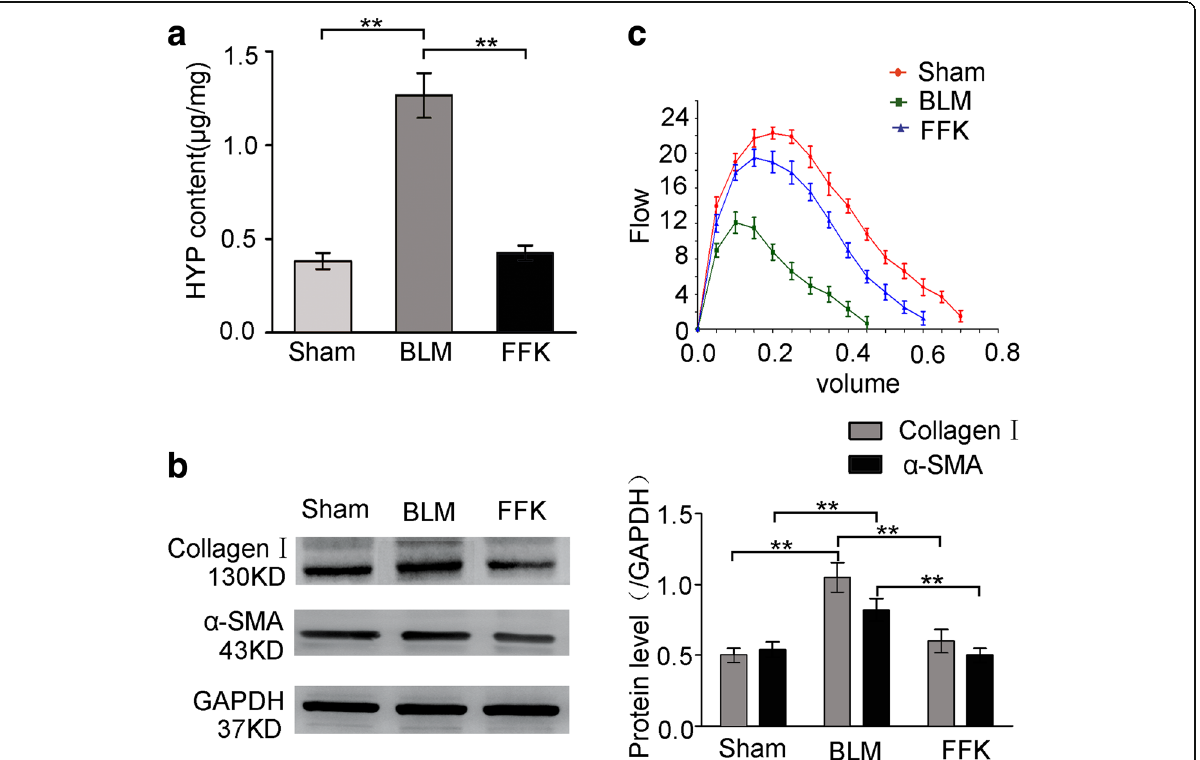
Fig. 2 FFK inhibited the indicators of pulmonary fibrosis in BLM-treated mice. a FFK remarkably inhibited the hydroxyproline (HYP) level in treated mice compared with that in the BLM-treated mice. b FFK significantly inhibited the collagen I and a-SMA expression in the treated mice compared with that in the BLM-treated mice. c FFK increased FVC in the treated mice compared with that in the BLM-treated mice. Data are shown as means ± SD, n = 6, ** P <